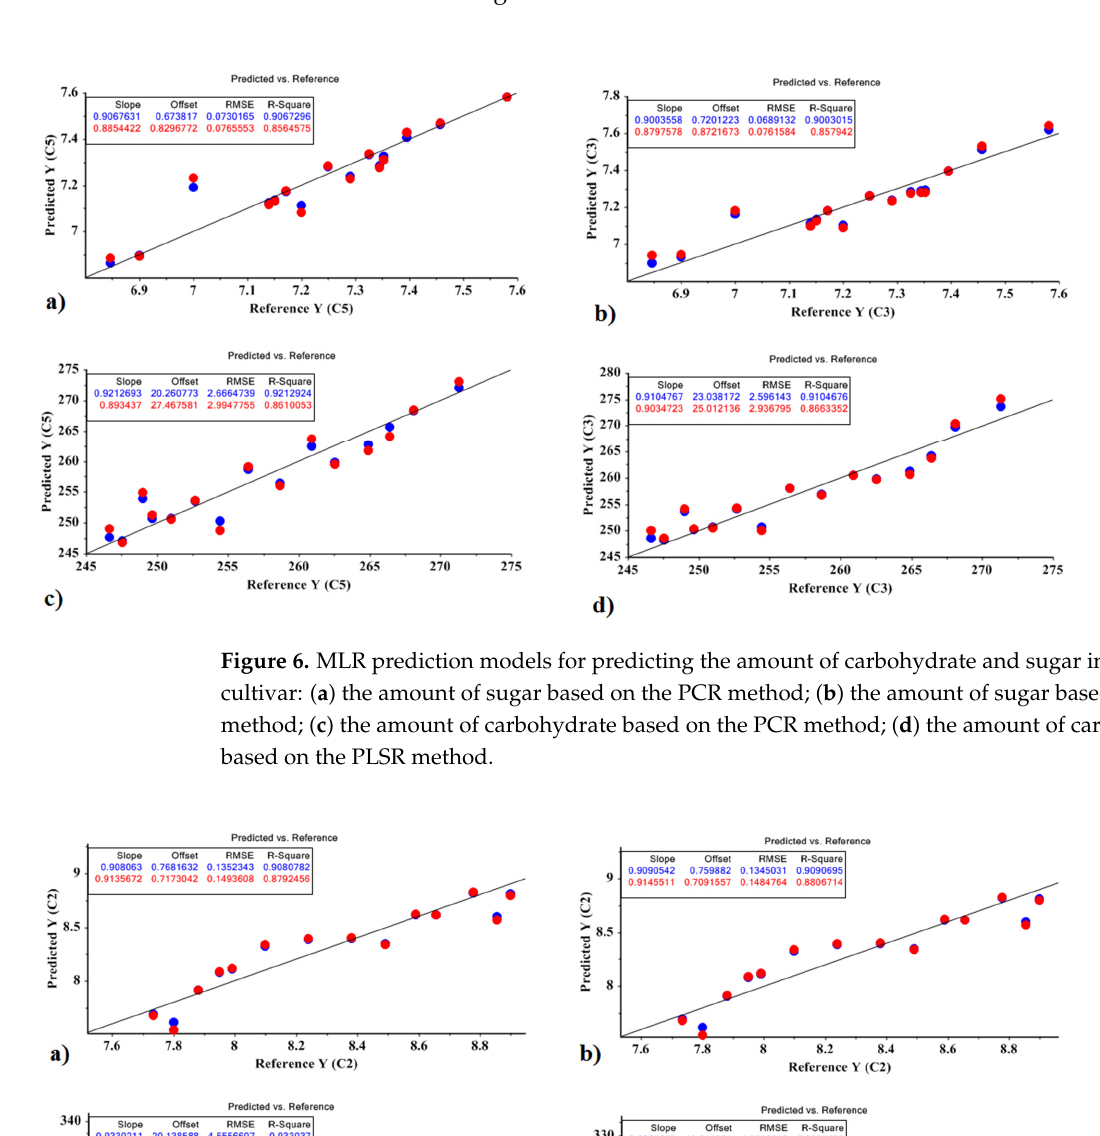
(23) The values obtained for the model were R 2 = 0.912 and RMSE = 5.016; p < 10 − 4 . 3.5. Support Vector Machine (SVM) To classify the samples, two methods were used—the C-SVM and the Nu-SVM— which contain four kernel functions: the radial basis function, the sigmoid function, the polynomial function, and the linear function. These methods have penalty coefficients of “C and Nu”, and a kernel coefficient of “ γ ”, which is used by a network search algorithm. Seventy percent of the data were used for training and 30 percent were used for testing; all input weights were one. The results of the SVM method are summarized in Table 4. Table 4. Results and comparison of Nu-SVM and C-SVM models subjected to the kernel functions. Kernel Function